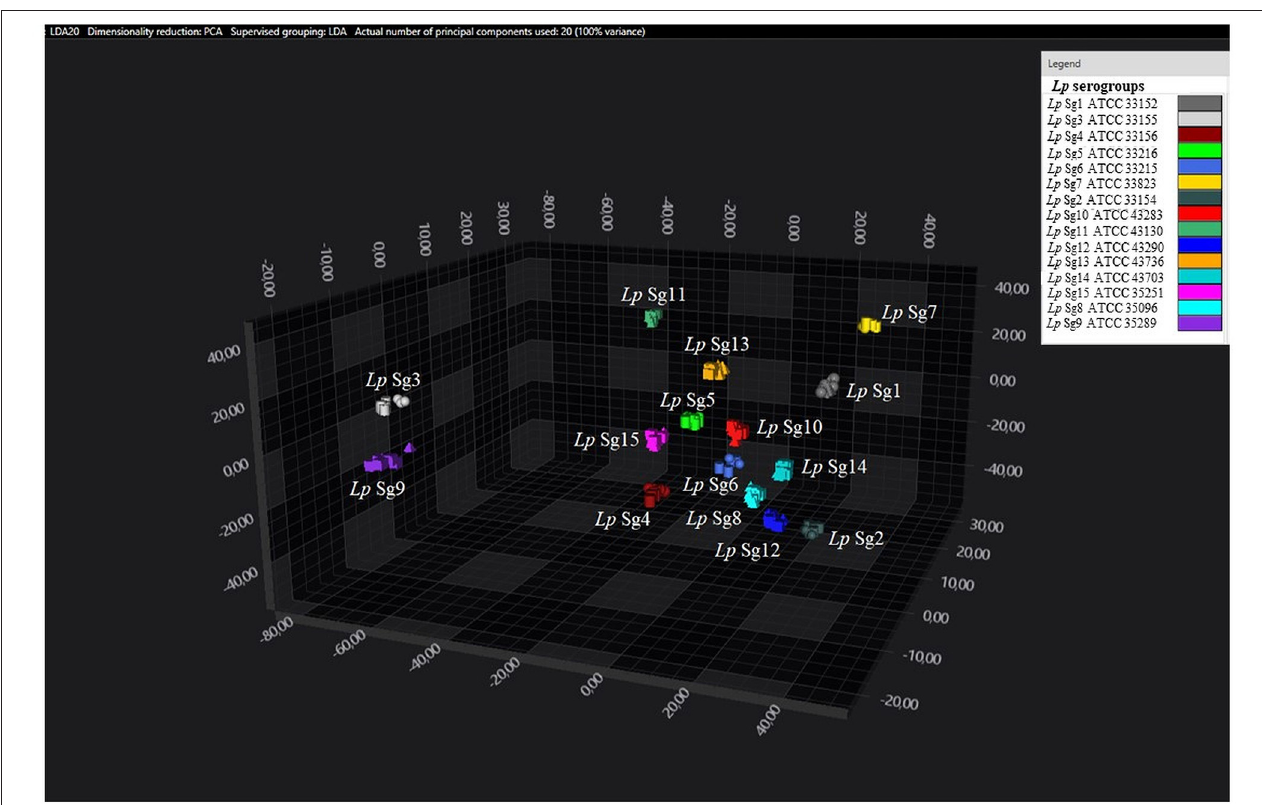
FIGURE 3 | 3D scatter plot of Lp ATCC reference strains. LDA was performed with 20 PCs. Each single circle, triangle, or square represent one single spectrum for each isolate (biological and technical replicate). Each serogroup is indicated by a different